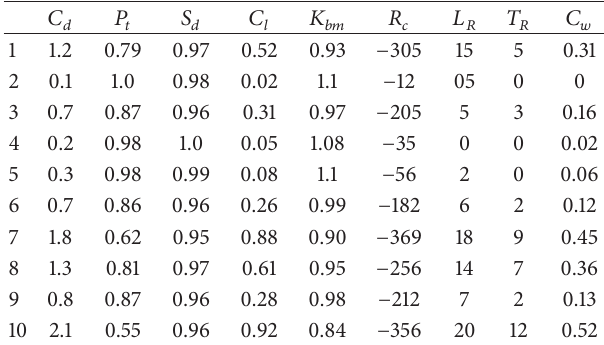
Table 1: Field data for bridge durability